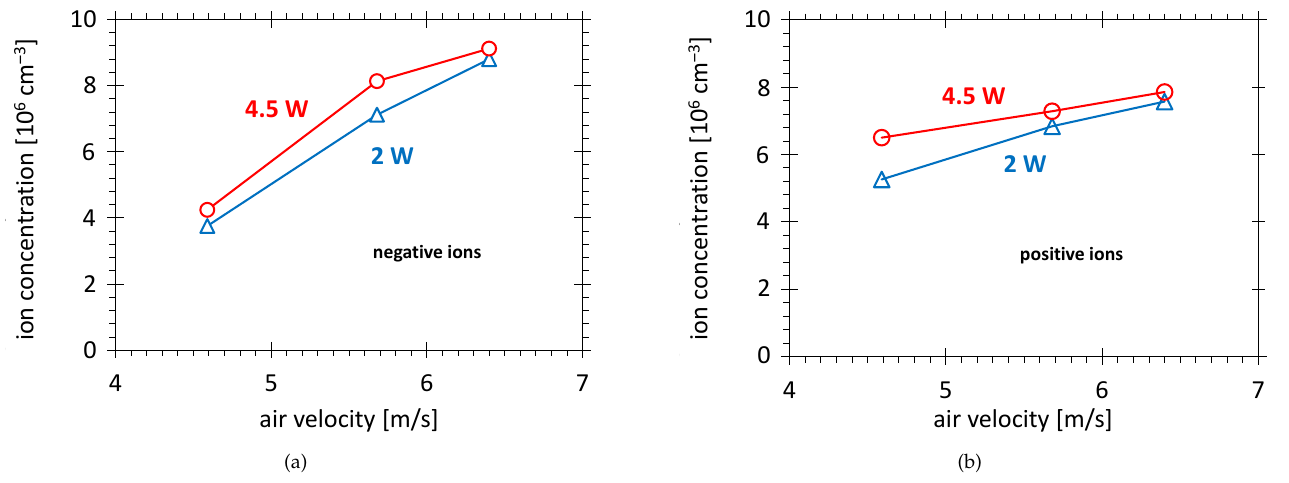
Figure 2. The ion concentration vs. air speed for ( a ) negative and ( b ) positive ions. The PCPG configuration 1, without filter, for two CeraPlas™HF power